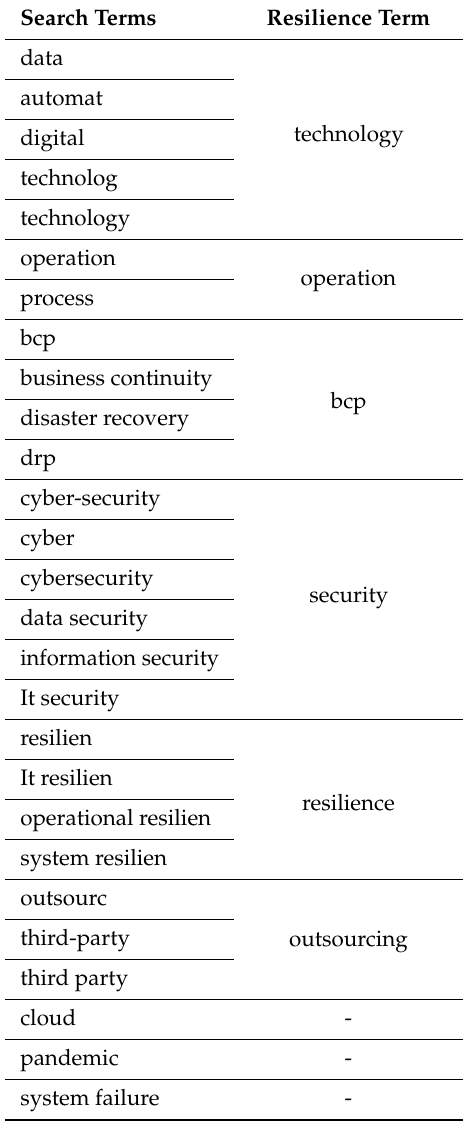
Table 3. List of terms mined for from the annual reports and the resilience term that they are grouped